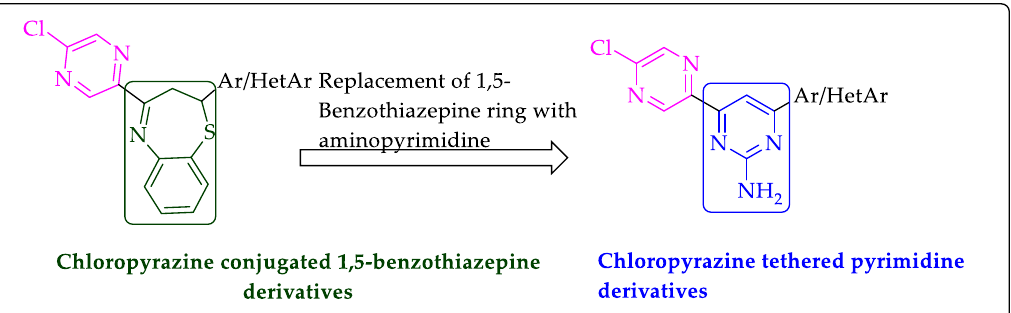
Figure 2. Design of chloropyrazine-tethered pyrimidine derivatives.